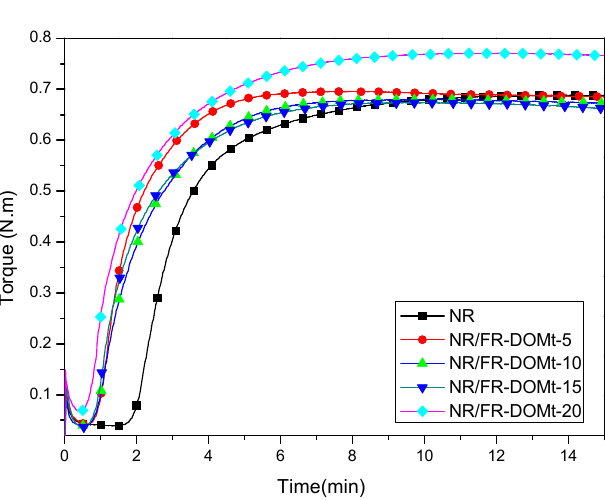
Figure 5. Cure curves of different NR nanocomposites.